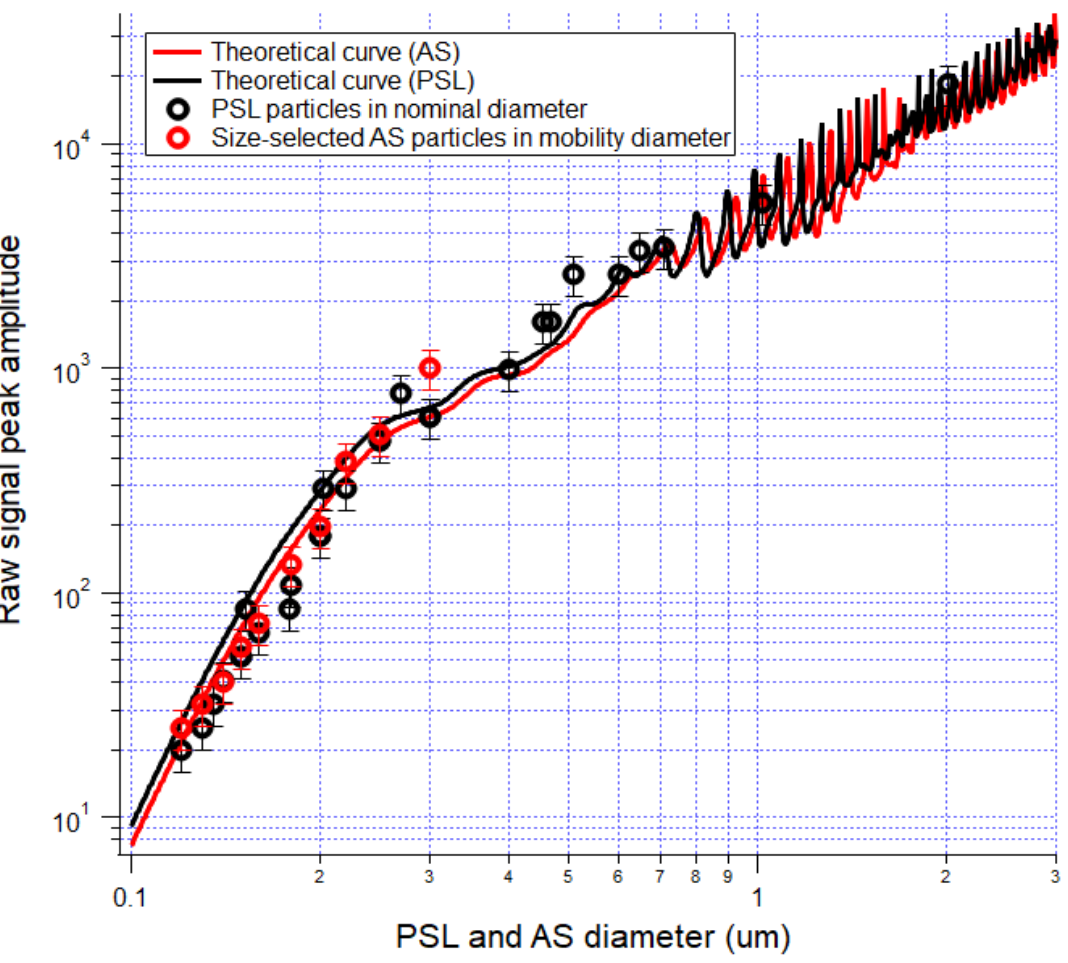
Figure 4. Calibration data of polystyrene latex (PSL) and ammonium sulfate particles. The scattering amplitudes for PSL and ammonium sulfate particles calculated using Mie theory as a function of particle diameter and scaled to the calibration results.